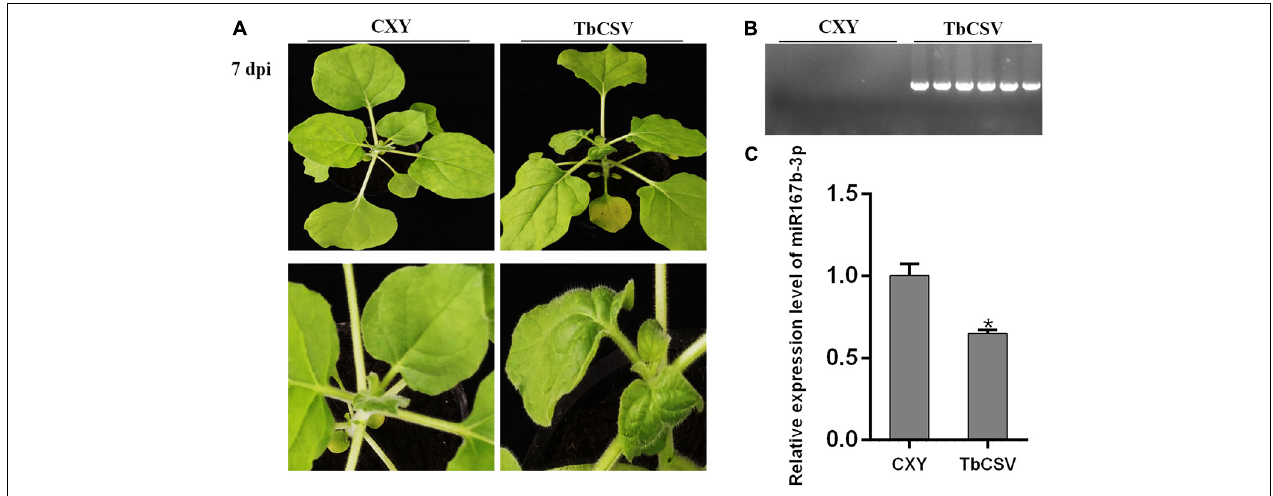
FIGURE 2 | TbCSV symptoms at 7 dpi and differential expression of nbe-miR167b-3p in TbCSV-infected N. benthamiana . (A) Leaf curling symptom caused by TbCSV in N. benthamiana leaves. (B) Analysis of TbCSV DNA through PCR. (C) Quantitative RT-PCR demonstrating the expression of nbe-miR167b-3p in TbCSV-infected in N. benthamiana plants. Significance of difference (* p < 0.05) was between the treatments was determined by the Student’s t -test.